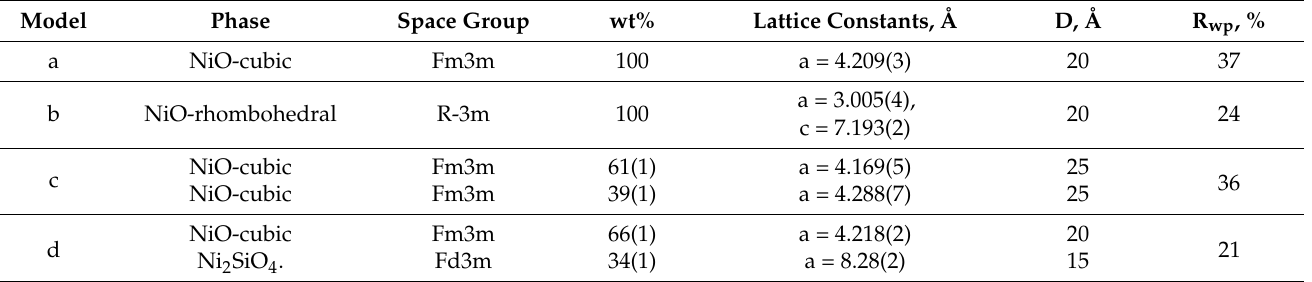
Figure 1. Experimental XRD pattern of NiO-SiO 2 . Bars show the positions and intensities of the diffraction peaks of cubic (black) and rhombohedral (red) NiO as well as cubic Ni 2 SiO 4 (blue). Miller indexes are given for cubic NiO. Table 1. Results of the Rietveld refinement using different models. R wp —weighted-profile